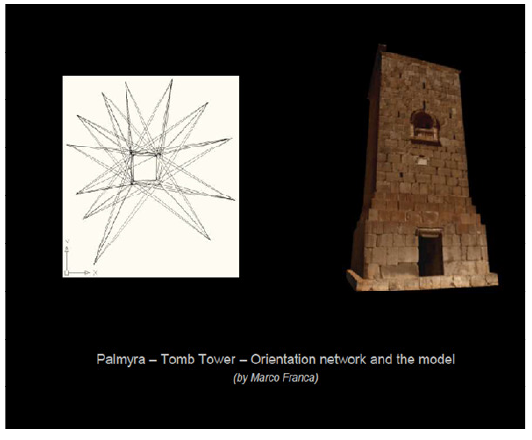
Figure 3. The Tower Tomb of Elahbel modelled by an Italian team led by G. Fangi. Courtesy G.